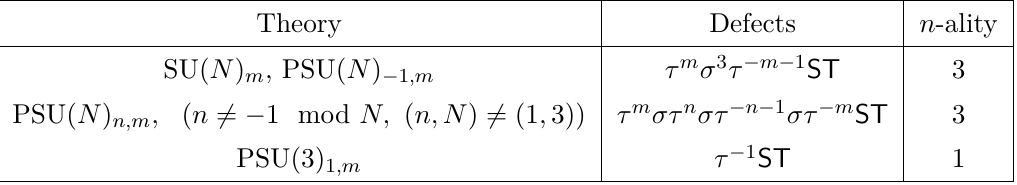
Table 6 . (Non-)invertible symmetries of su ( N ) with N prime at τ YM = e 2 πi/ 3 .